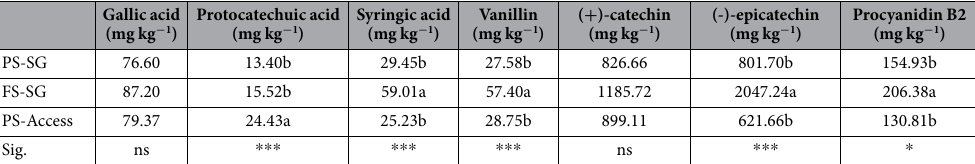
Table 8. Phenolic compounds composition at harvest in seeds of SG (susceptible clone R10) and accession 72- 096 (resistant). PF = partially sprayed. FS = fully sprayed. Data expressed as mg kg − 1 of seed dry weight. * and *** denote significant differences between treatments at P < 0.05 and 0.001 according to within column mean separation performed with SNK test and showed by small letters. ns = not